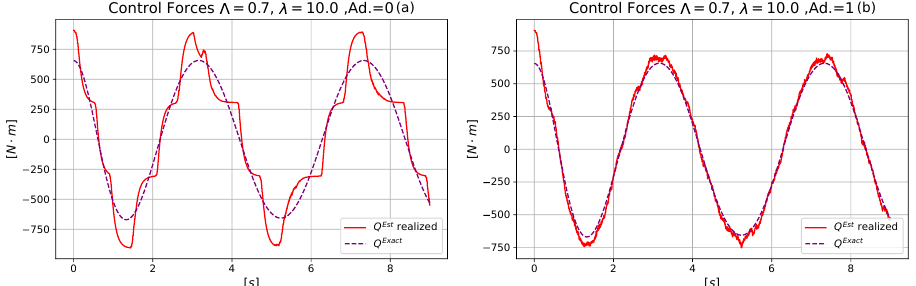
Figure 6. The phase trajectories for the maximal amplitude and circular frequency of the nominal trajectory for which the adaptive controller was able to use only the originally learned data (note that δ q 1 ≈ 0.628rad, and δ ˙ q 1 = 2.0rad · s − 1 ). ( a ): Non-adaptive phase trajectory for the controlled variable q 1 , ( b ): adaptive phase trajectory of the controlled variable q 1 . ( c ): Non-adaptive phase trajectory of the coupled mass point. ( d ): Adaptive phase trajectory of the coupled mass point.